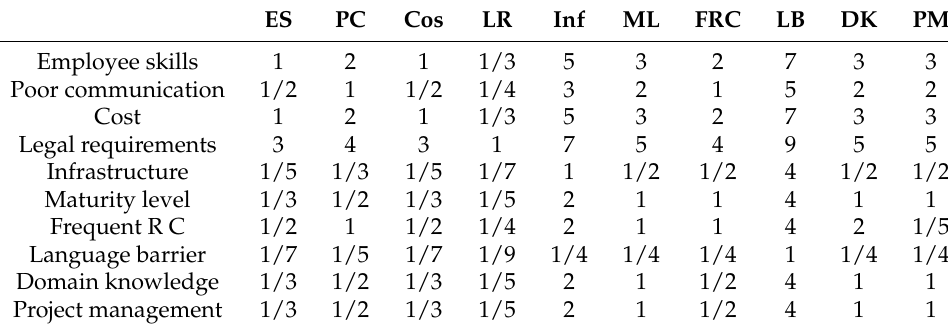
Table 4. Assigning weights to criteria with respect to the goal.